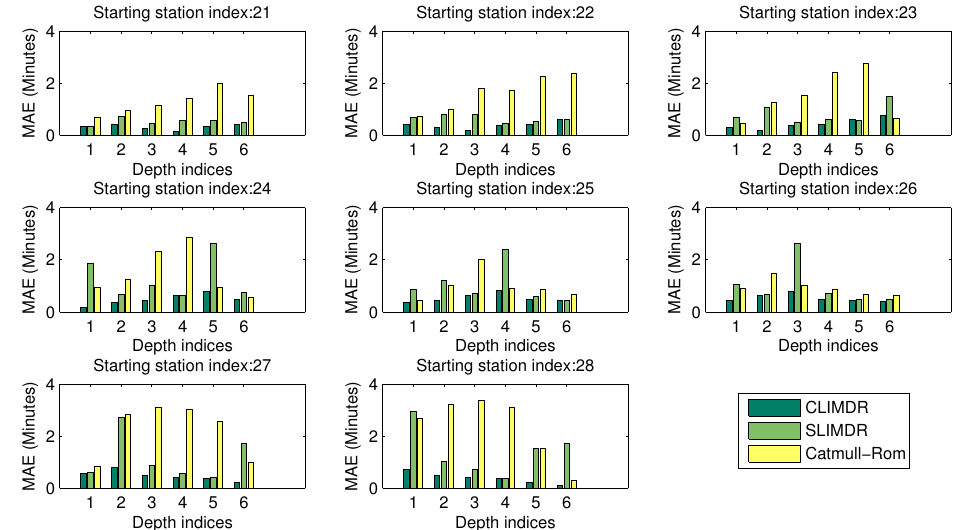
Figure 21. Comparisons of the MAE performances for six-depth missing data